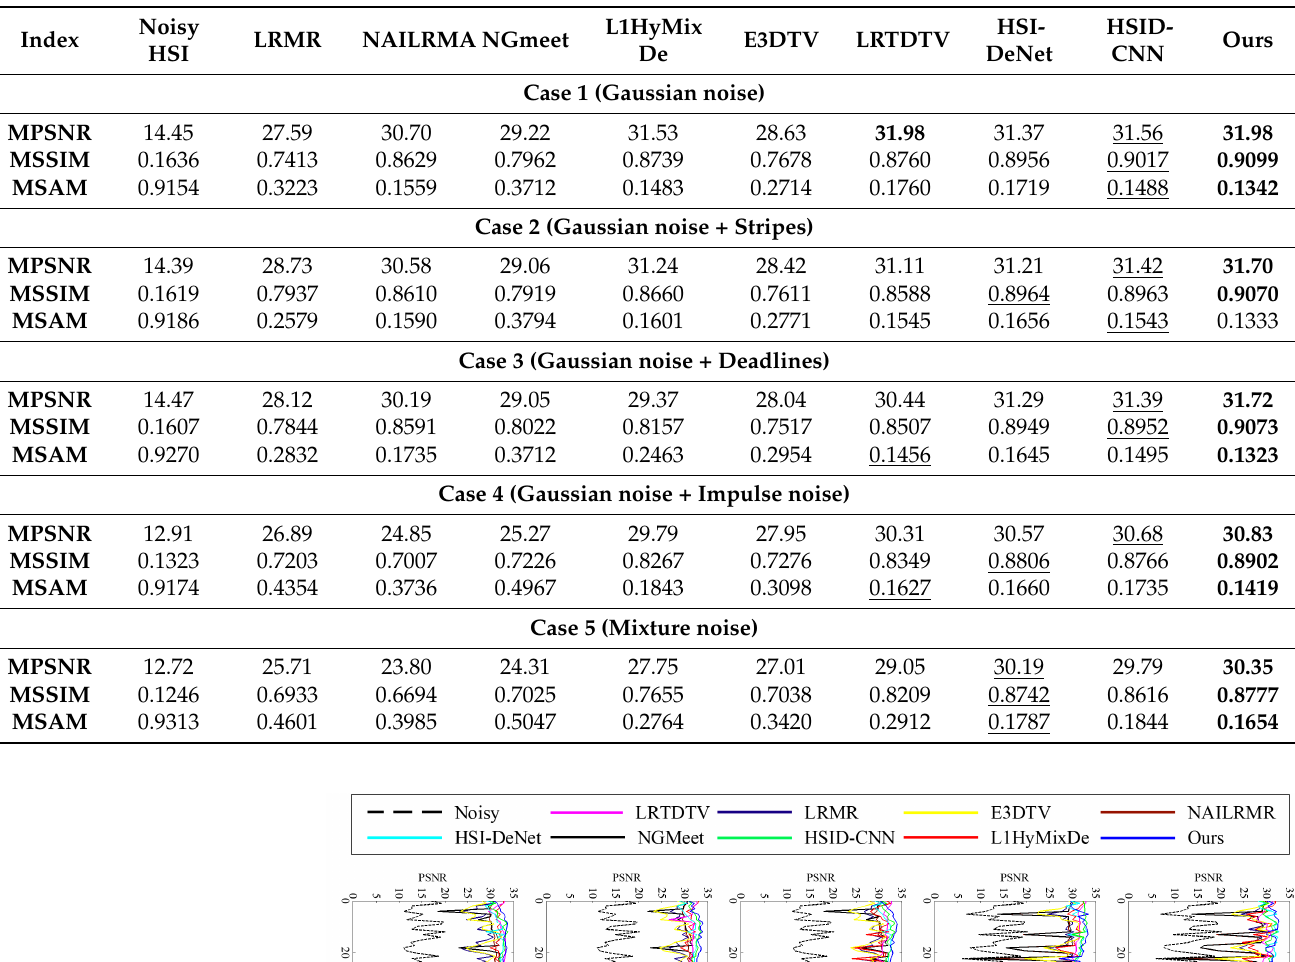
Table 3. Quantitative assessment of different algorithms applied to Pavia Centre data with mixture noise cases.